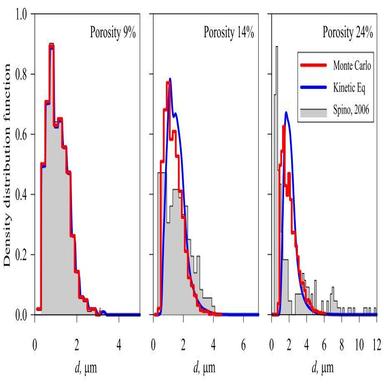
Normalized pore size distribution functions at different porosity values in comparison with experimental histograms of Spino et al. for the fuel sample with the average burnup 98 GWd/t. The first histogram (at 9% porosity) was used as the initial condition for calculations at higher porosities (14 and 24%).